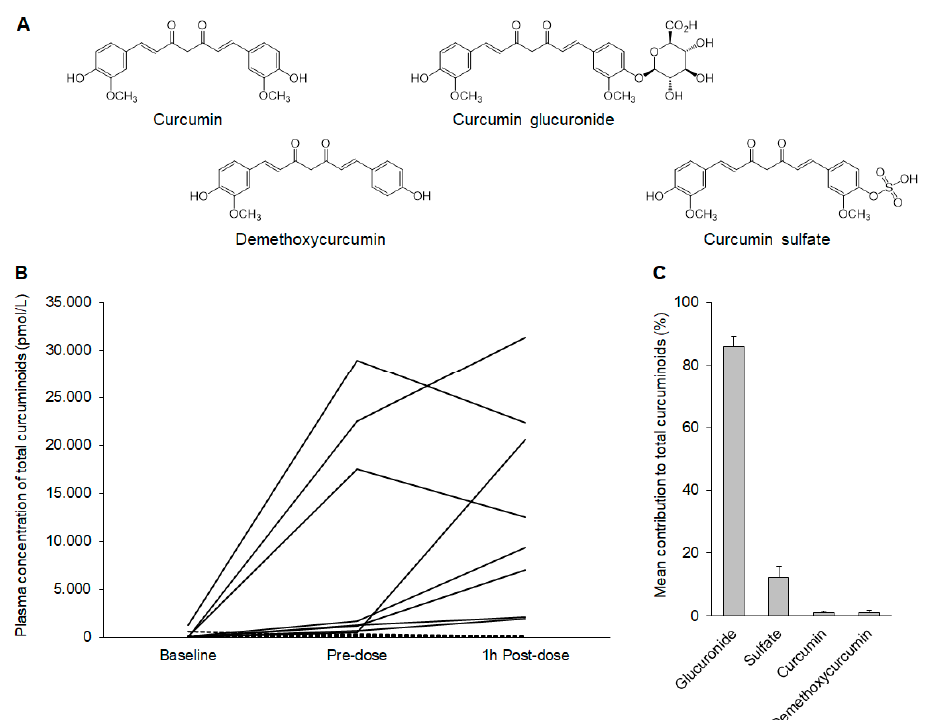
Figure 2. Analysis of plasma curcuminoids in samples collected at baseline and on two occasions on the final day of the study, immediately prior to the last dose and 1 h post-dose. Only a subset of patients were selected at random for LC-MS/MS analysis. ( A ) Structures of curcumin, demethoxy-curcumin, and the mono-conjugated sulfate and glucuronide metabolites analyzed in the samples. ( B ) Plasma concentrations of the total curcuminoids in each patient at the three time points. Solid lines correspond to the patients in the active arm (n = 8), and the dashed lines indicate the patients in the placebo arm (n = 7). ( C ) The profile of curcumin species detected in the patients in the active arm 1 h post-dose. Values shown are the mean (±SEM) contribution of each curcumin species detected to the total quantifiable curcuminoids for the 8 patients. The profile was similar in samples collected immediately prior to the last dose (not shown).